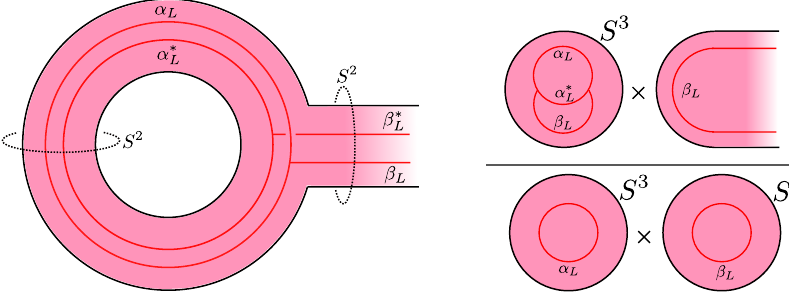
Figure 12 . (Left) One of the handles from the right sub(cid:12)gure of (cid:12)gure 11, with S 2 surgery performed at the indicated locations. (Right) The equivalent path-integral